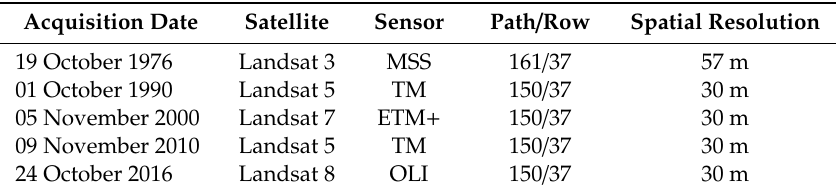
Table 1. Landsat images used for land cover mapping.